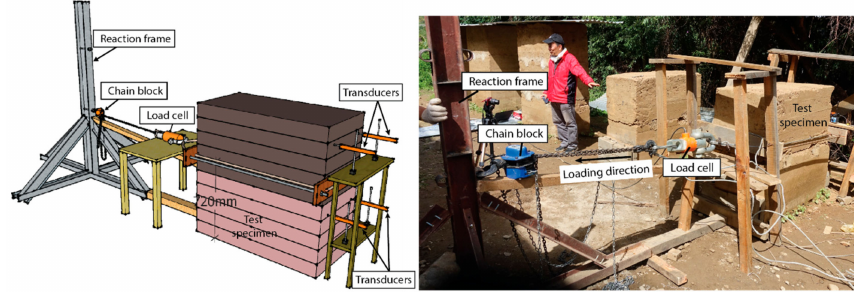
Figure 6. Test set up and